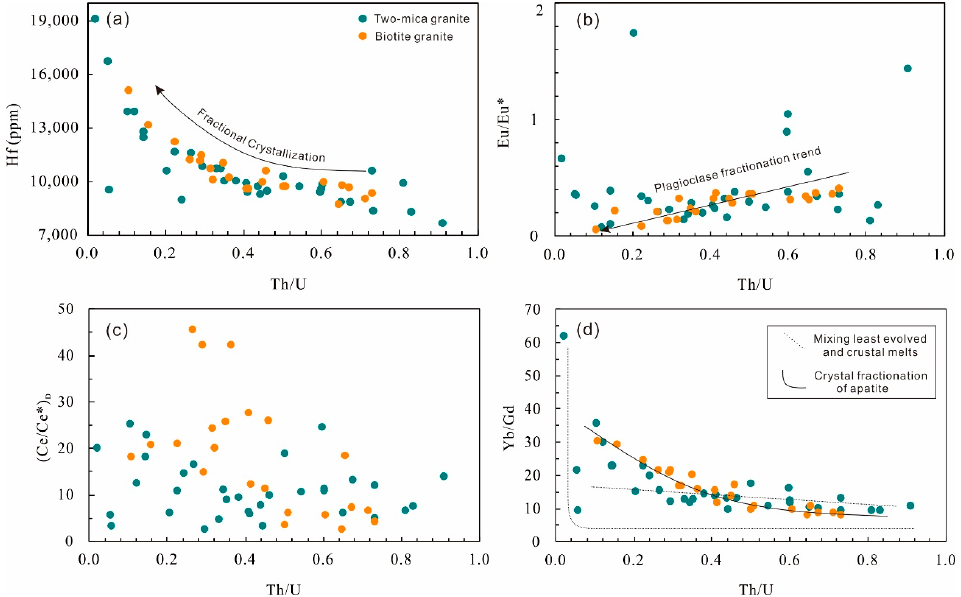
Figure 2. Hafnium ( a ), Eu/Eu* ( b ), (Ce/Ce*) D ( c ) and Yb/Gd ( d ) vs. Th/U of zircons from the Nashwaak Granite.